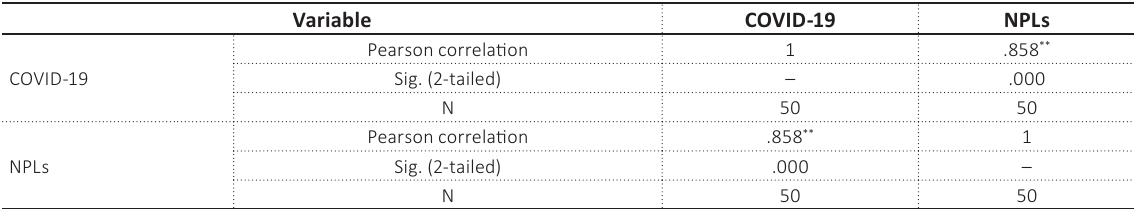
Table 3. Validity test results